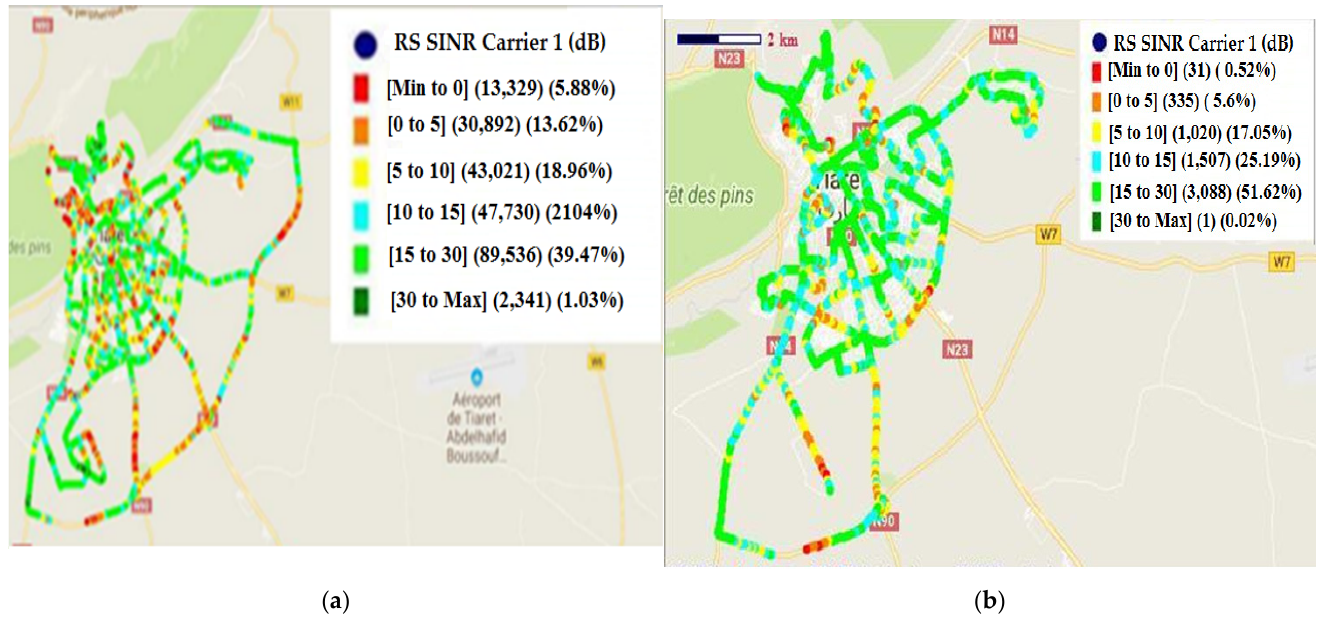
Figure 11. SINR distribution: ( a ) before treatment; ( b ) after treatment.